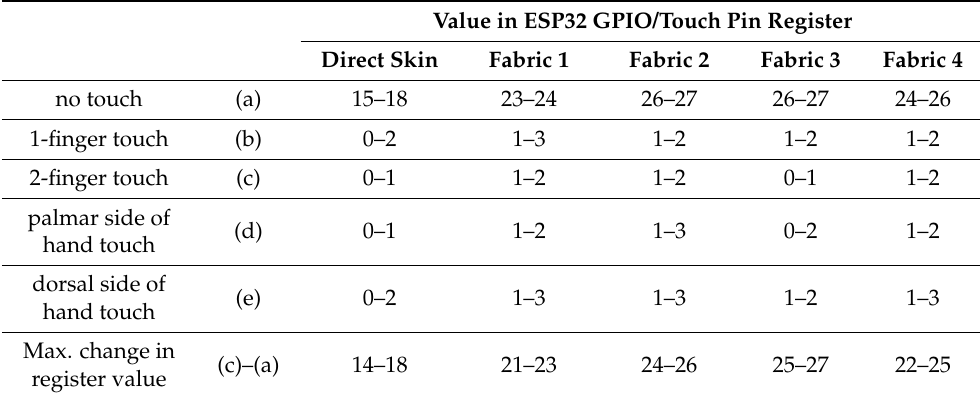
Table 2. Performance of off-the-shelf FSR for different types of touches when placed on the